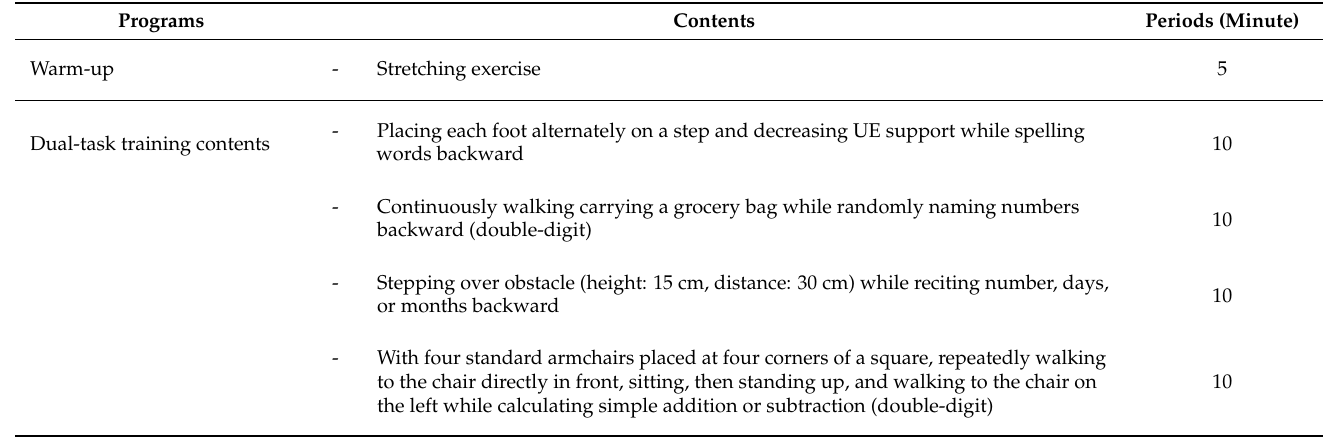
Table 1. Dual-task training